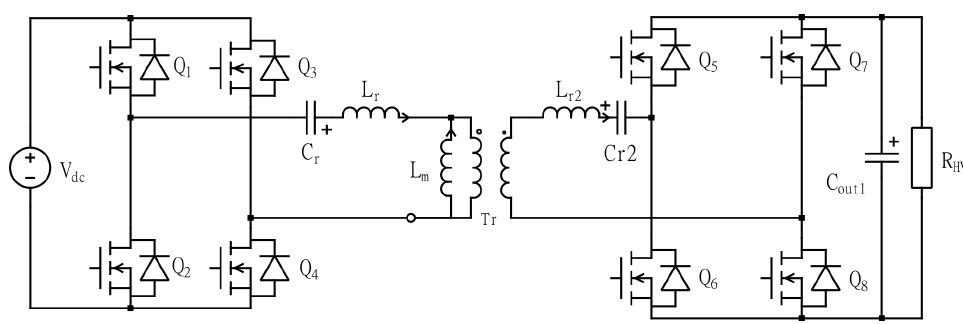
Figure 5. Symmetric CLLC converter topology.